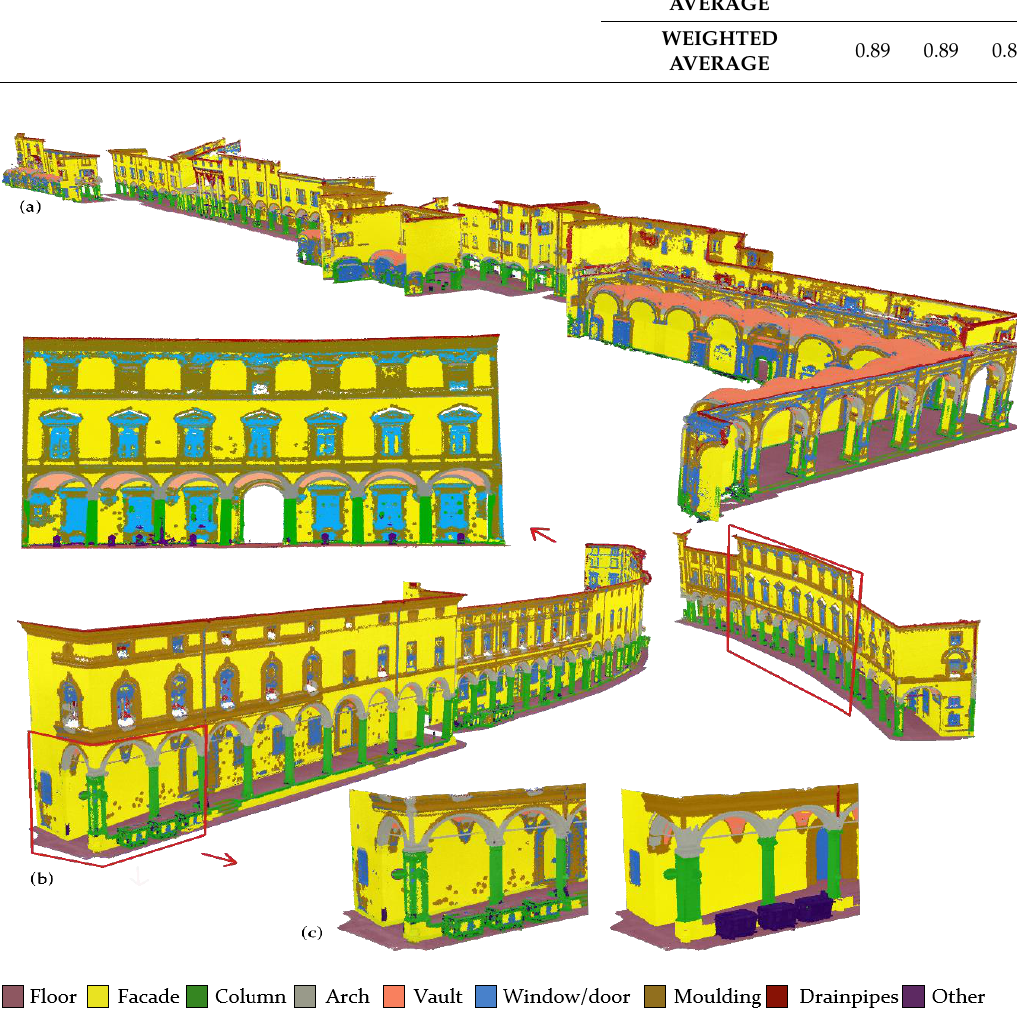
Figure 9. Classification results: generalisation level #2: ( a ) dataset B, ( b ) dataset C, ( c ) a comparison between the prediction and the ground truth shows the classification errors within the class other. Table 5. Evaluation metrics: generalisation level #3, dataset D. The most critical F1 values are reported in italics ( window and moulding classes).